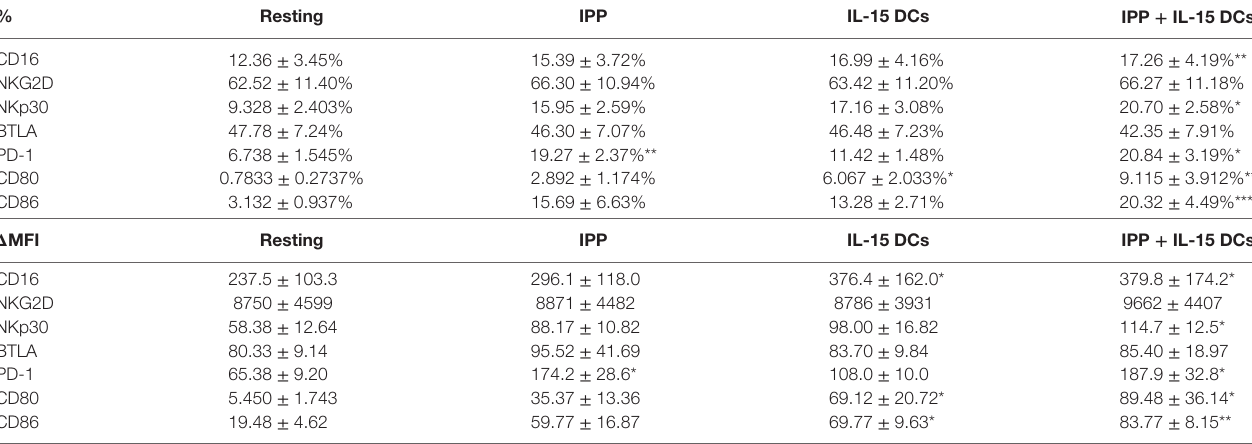
TaBle 2 | γδ T cell phenotype of healthy donors after 48 hours of culture with IPP, IL-15 dendritic cells (DCs) or both. % resting iPP